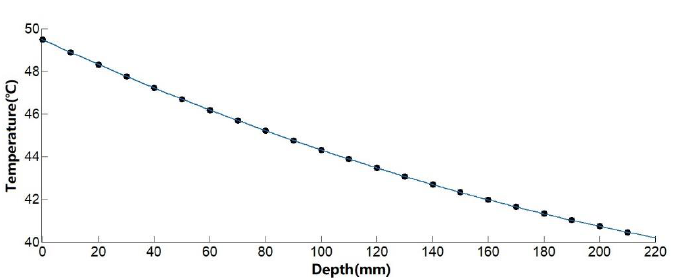
Figure 7. The quadratic function fitting results of the relationship between the slab track depth and the temperature at 14:00. Using the same method, the temperature data under various working conditions